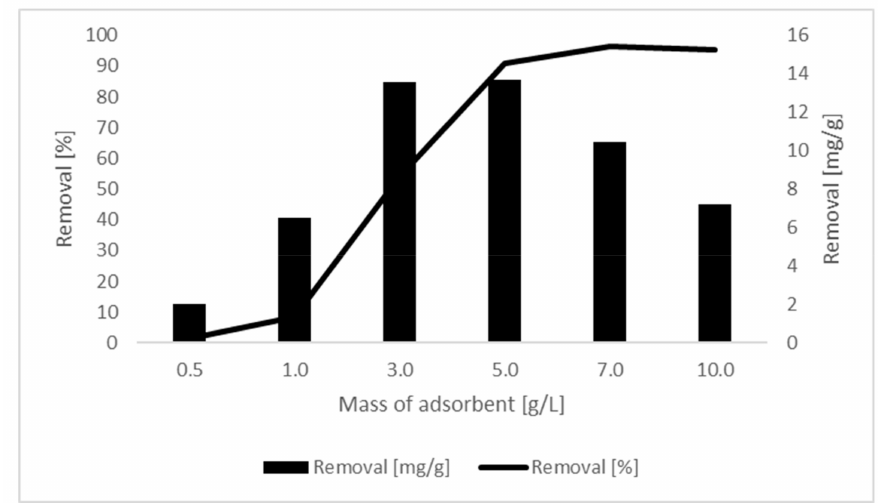
Figure 4. Zinc removal [%] and adsorption capacity [mg / g] as a function of the mass of the adsorbent. Experiments were done duplicated and the range of results were at maximum 3 percentage points in values of removal % and at maximum 0.5 mg / g in adsorption capacity determinations.